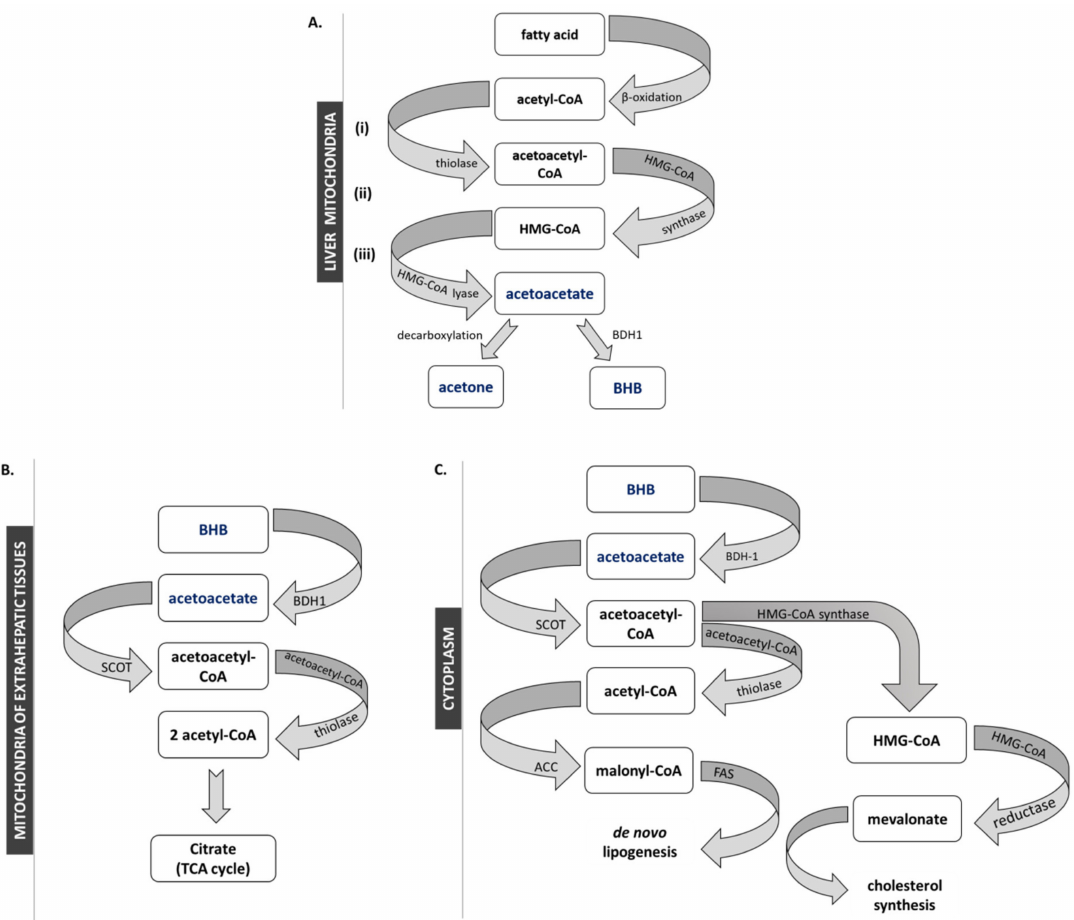
Figure 1. Metabolism of ketone bodies. ( A ) Synthesis of ketone bodies in the liver mitochondria. ( B / C ) Alternative metabolic fates of ketone bodies. ( B ) Funneling in the Krebs via succinyl-CoA:3-ketoacid coenzyme A transferase (SCOT) in mitochondria of extrahepatic tissues, and ( C ) their being used as metabolic precursors in cholesterol synthesis or de novo